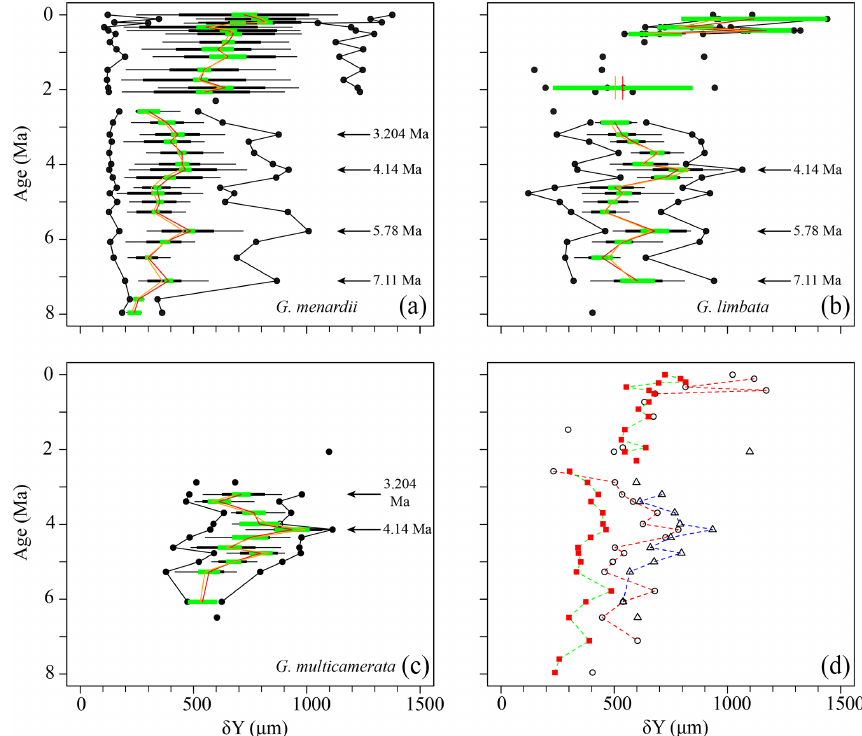
Figure 6. Axial length ( δY ) in keel view (inµm) versus time (Ma) at ODP Hole 667A for (a) G. menardii , (b) G. limbata , (c) G. multicamerata and (d) the mean values of the three species. See Fig. 5 for the explanation of the